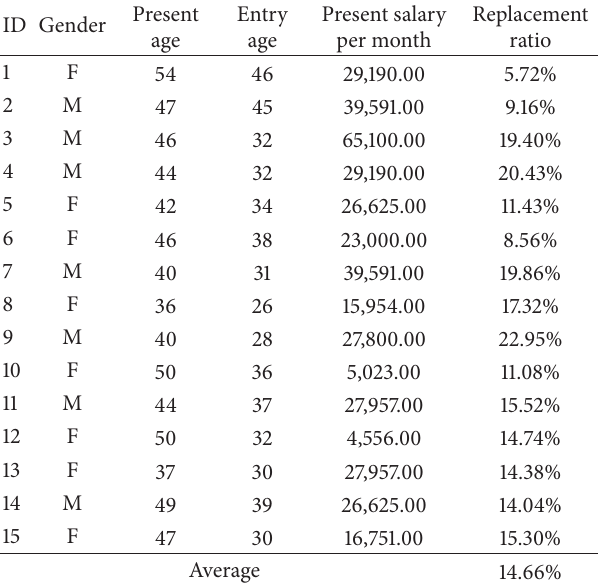
Table 6: Replacement ratio for modified defined contribution pension plan.